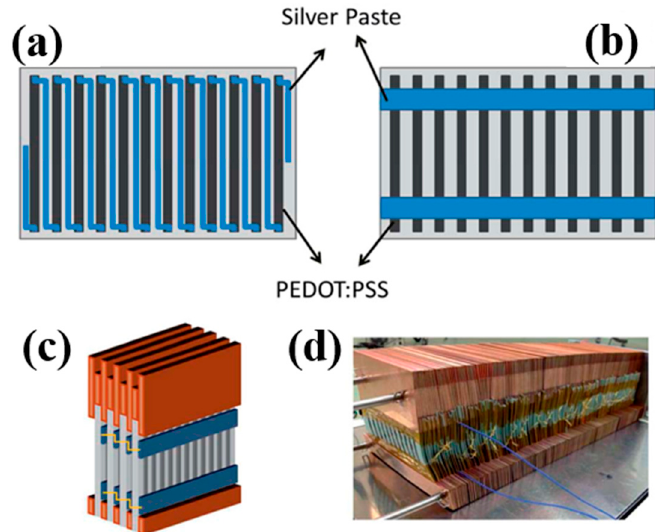
Figure 12. The schematic representation of the ( a ) series and ( b ) parallel PEDOT:PSS arrays; ( c ) the schematic and ( d ) photograph of the PEDOT:PSS modules sandwiched between copper plates. Reprinted with permission from [132]. Copyright 2014 The Royal Society of Chemistry.